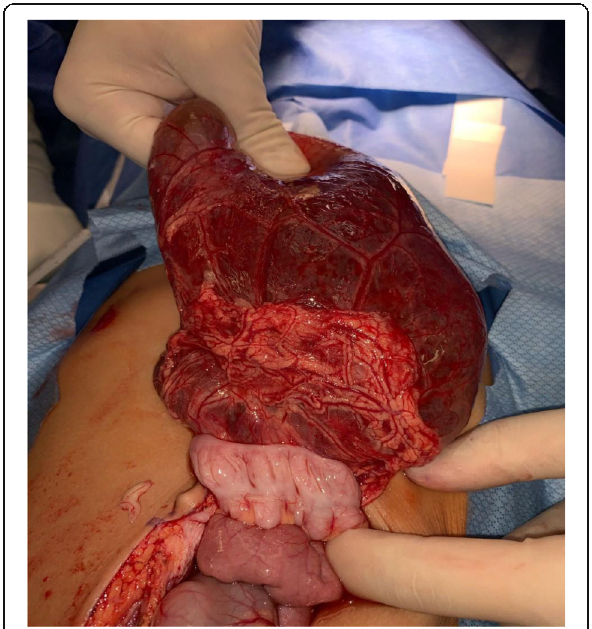
Fig. 2 After being freed from the omentum laterally and inferiorly, the cyst was reflected cephalad. Note the adherence of the cyst to the transverse colon. The superior origin of the cyst was followed into the lesser sac, where it was intimately associated with the tail of the